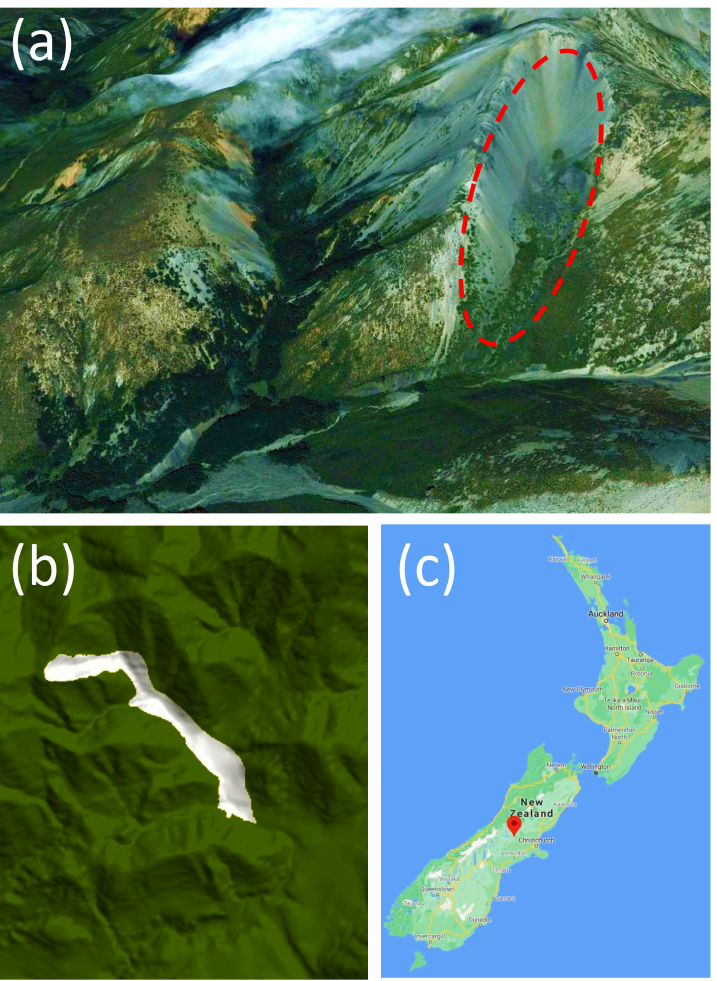
Figure 4. ( a ) A general view of the source area, ( b ) the area impacted by the avalanche, and ( c ) its location (Google